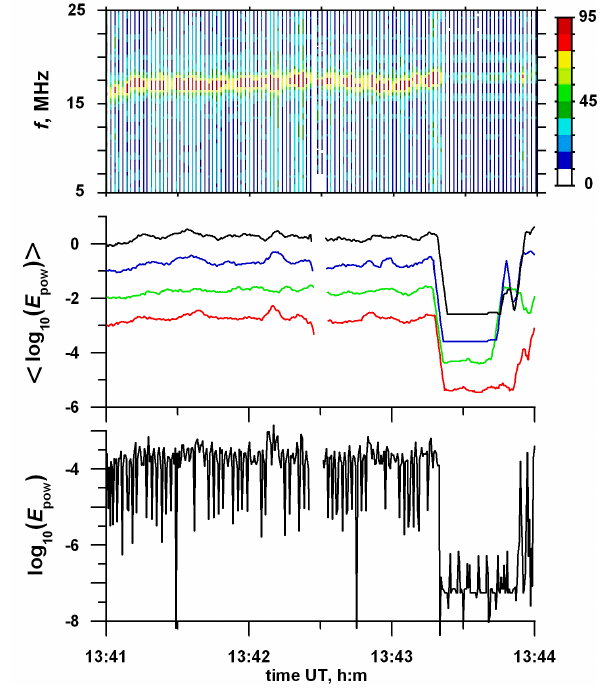
Fig. 2. (a) Frequency-time spectrograms obtained by the WHISPER instrument aboard Sc1 in the Earth’s electron foreshock on 29 April 2001 (event 47). The electric field strength in V rms Hz − 1 / 2 is color coded and plotted in dB over 10 − 7 V rms Hz − 1 / 2 . The correspond- ing color scale is shown on the right of the spectrogram. (b) Profiles for log 10 (E pow ) measured aboard all four spacecraft upon sliding averaging over 4s time intervals. Red, green, blue, and black lines correspond to Sc1, Sc2, Sc3, and Sc4, respectively. To ease the comparison, the curves showing the measurements aboard Sc2, Sc3, and Sc4 are shifted upward by 1, 2, and 3, respectively. (c) Profiles for log 10 (E pow ) measured aboard Sc1. Strong modulation due to spacecraft spin is easily